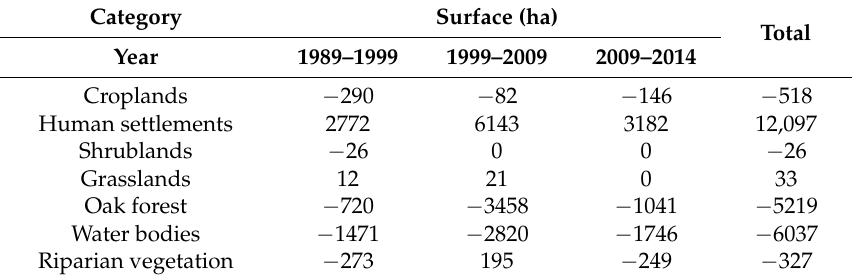
Table 5. Change dynamics of seven types of land use in the urban and peripheral areas of Chihuahua City. Positive and negative numbers indicate gains and losses of surface, respectively.